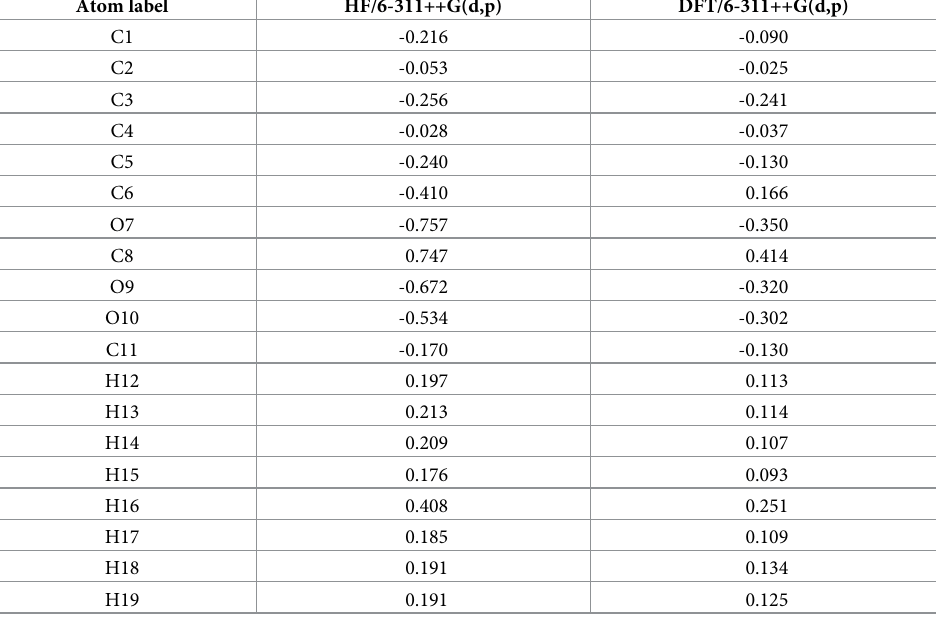
Table 3. Mulliken atomic charges for optimized geometry of methyl